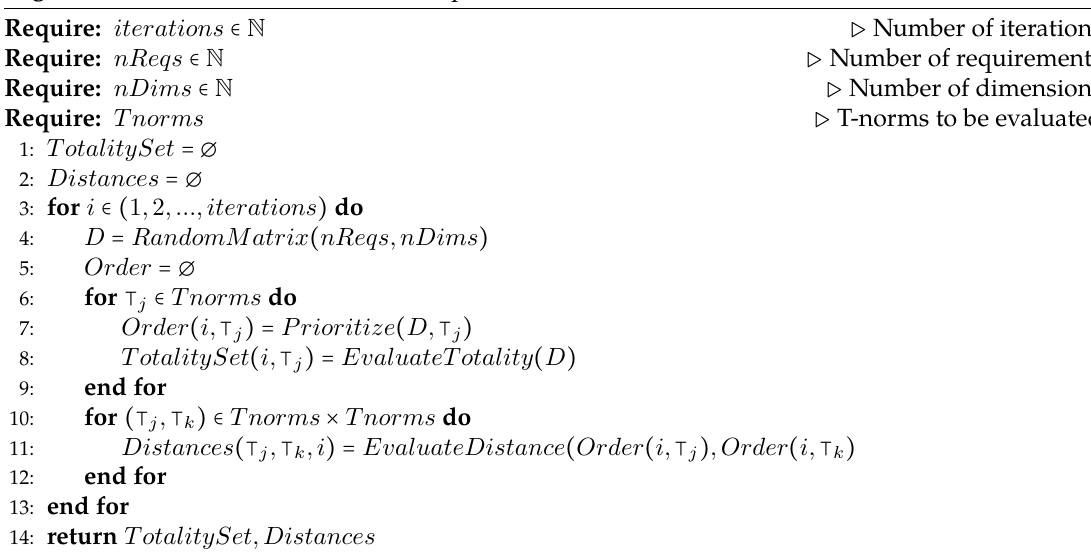
Algorithm 2 Procedure for T-norms